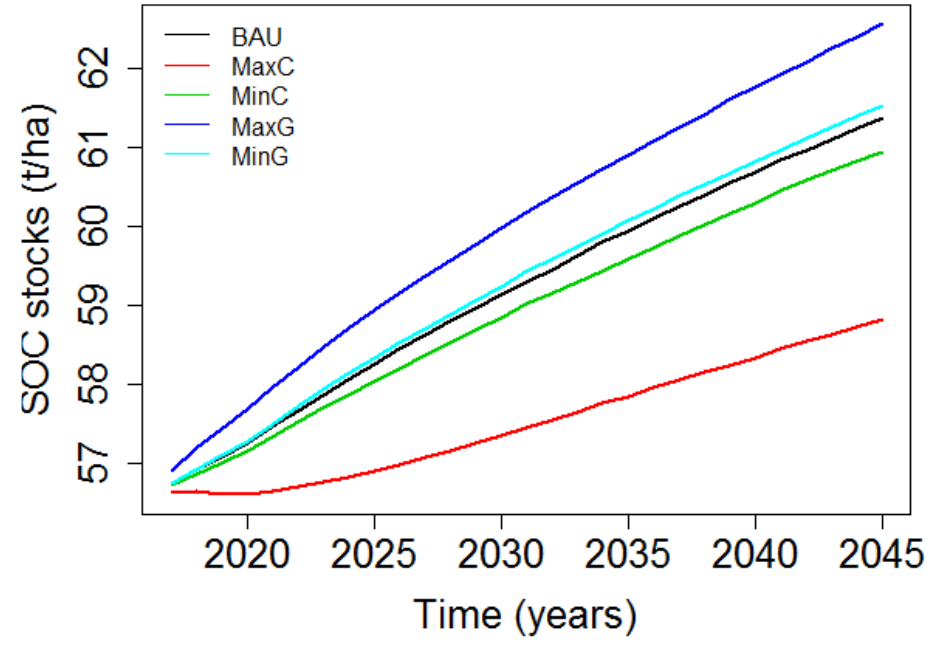
Figure 8. The simulated effect of different landscape scenarios (BAU, MaxC, MinC, MaxG, MinG) under BAU climate on SOC dynamics in the 0 – 100 cm soil layer.